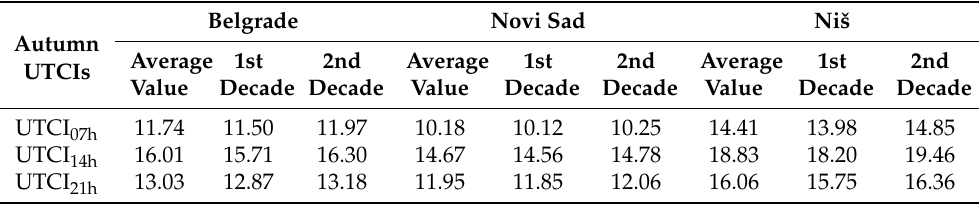
Table 5. Average autumn UTCIs values in Belgrade, Novi Sad, and Niš for the period 1999–2018, and